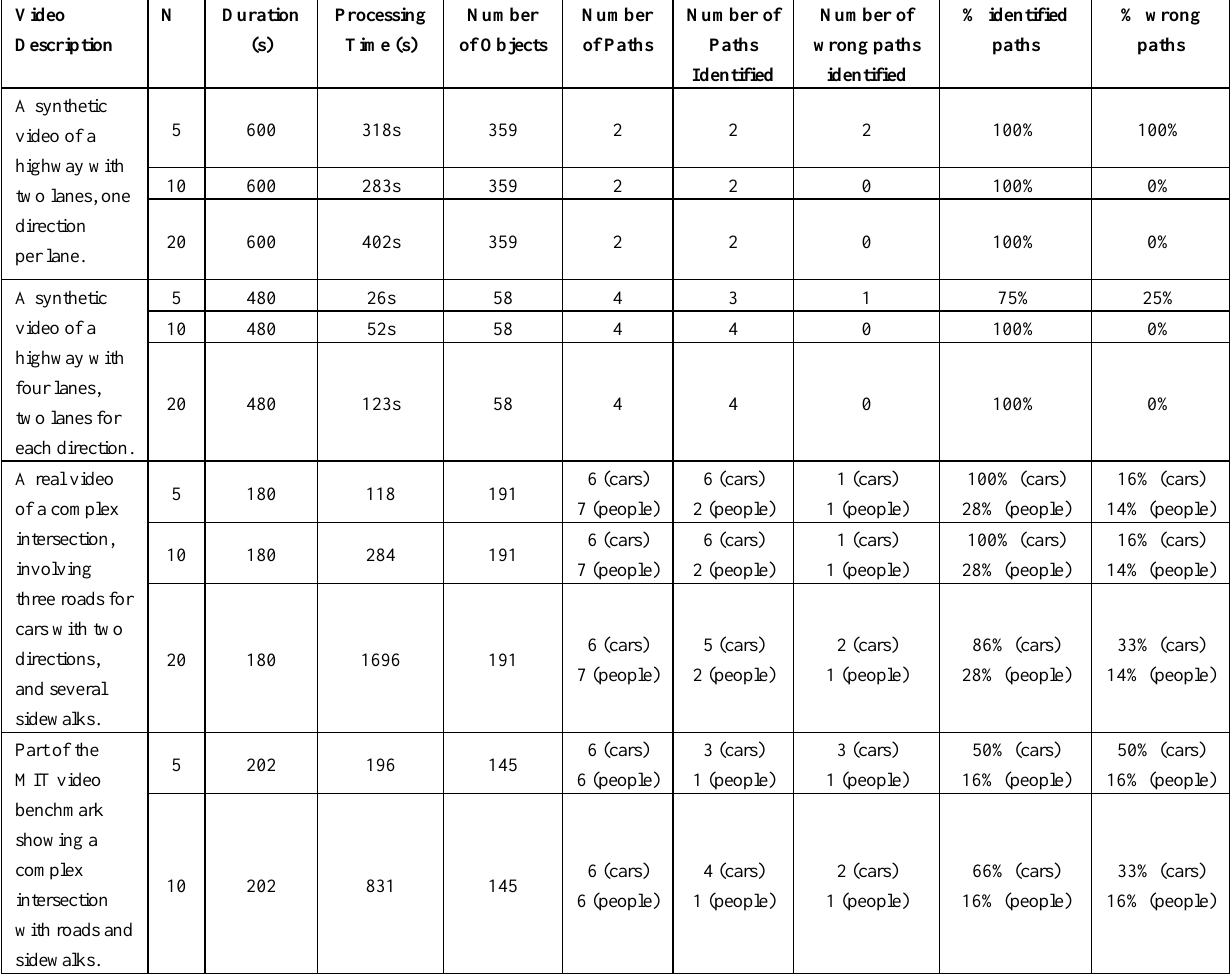
Table 1. Performance results for the route detector. N is the number of points per